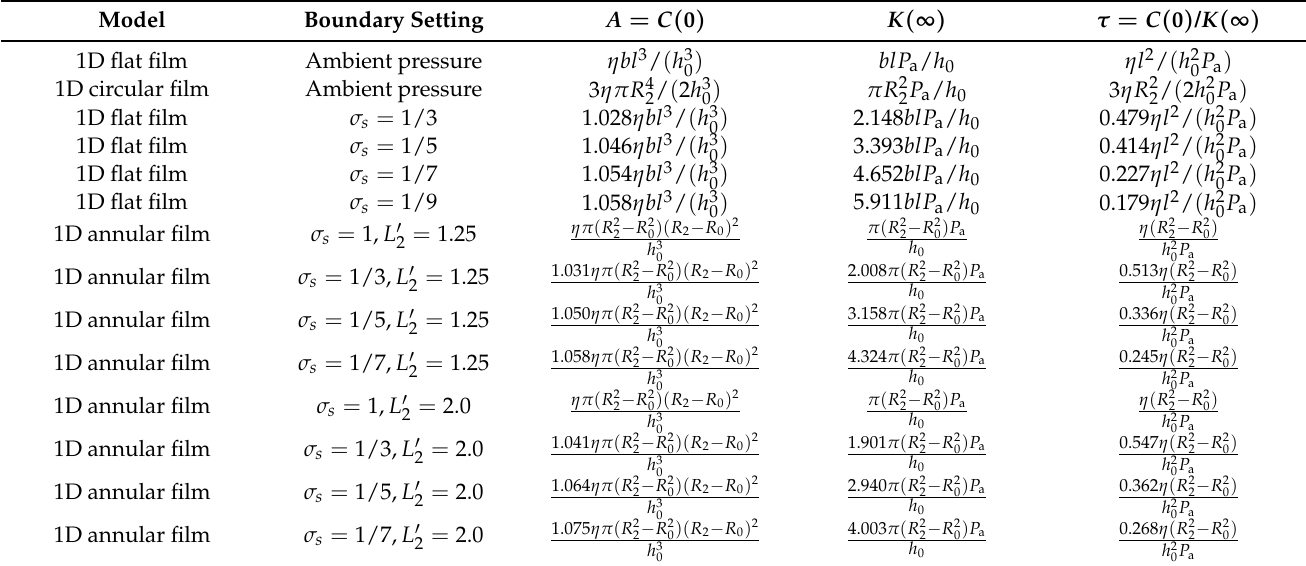
Table 3. Parameters of a typical aerostatic thrust